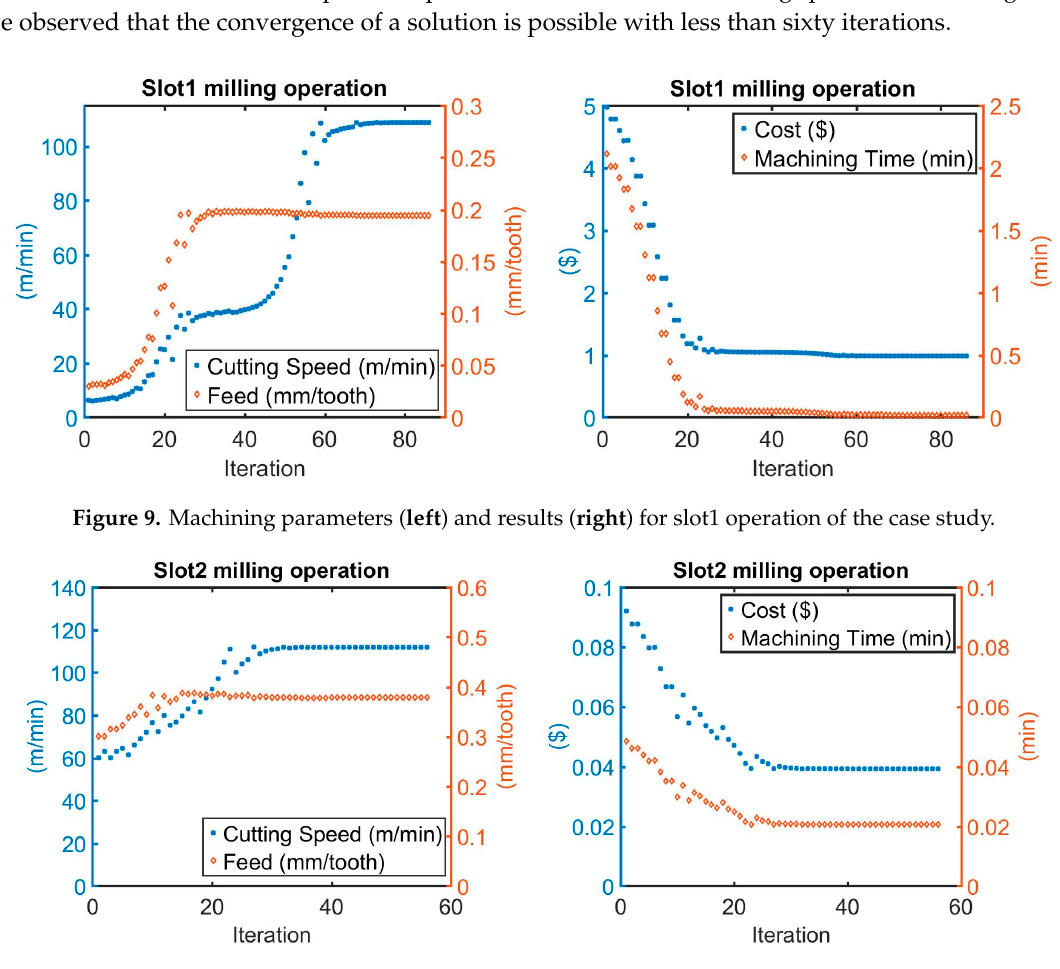
Figure 10. Machining parameters ( left ) and results ( right ) for slot2 operation of the case study. Table 8. Initial and optimum parameters of slot1 milling. Table 9. Initial and optimum parameters of slot2 milling.